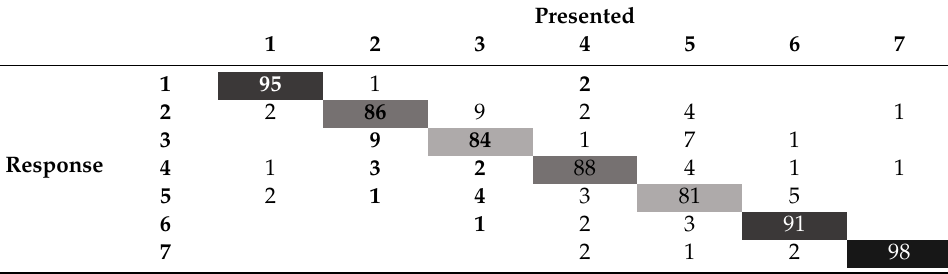
Table 5. Confusion matrix of the third experiment’s